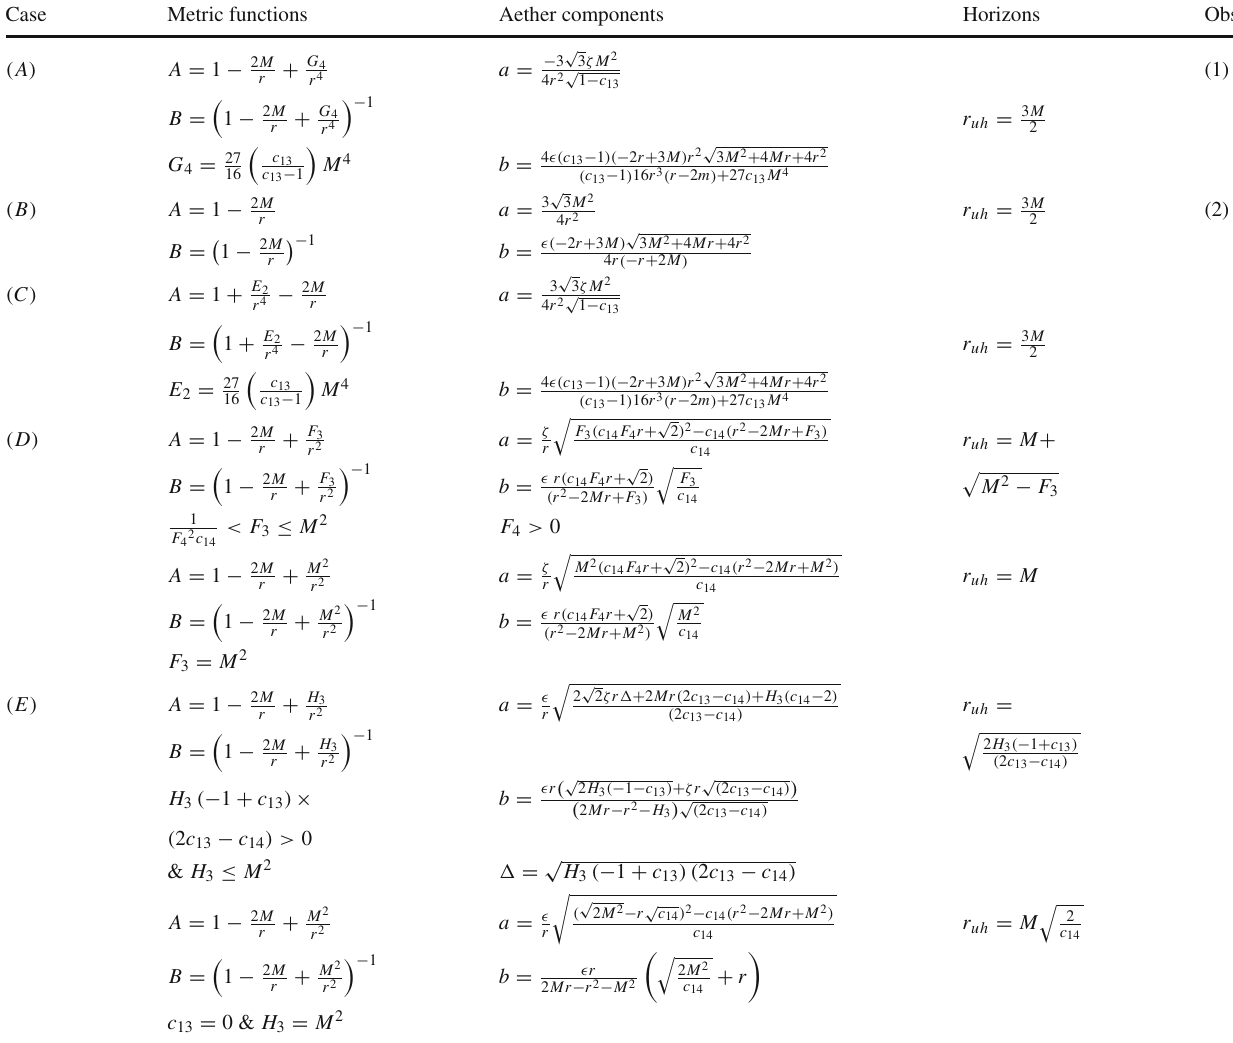
Table 2 Summary of the solutions